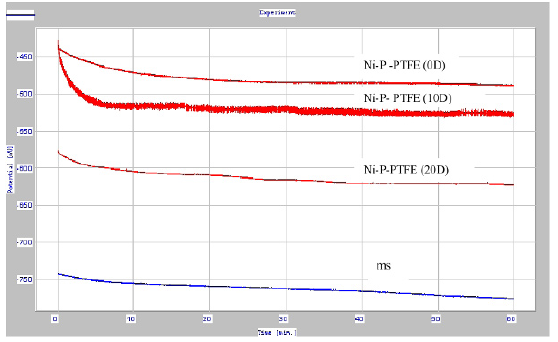
Figure 5. OCP curves for mild steel (ms) and Ni-P-PTFE coatings after different exposure times in 3.5% solution of NaCl: zero days (0D), ten days (10D), and twenty days(20D).